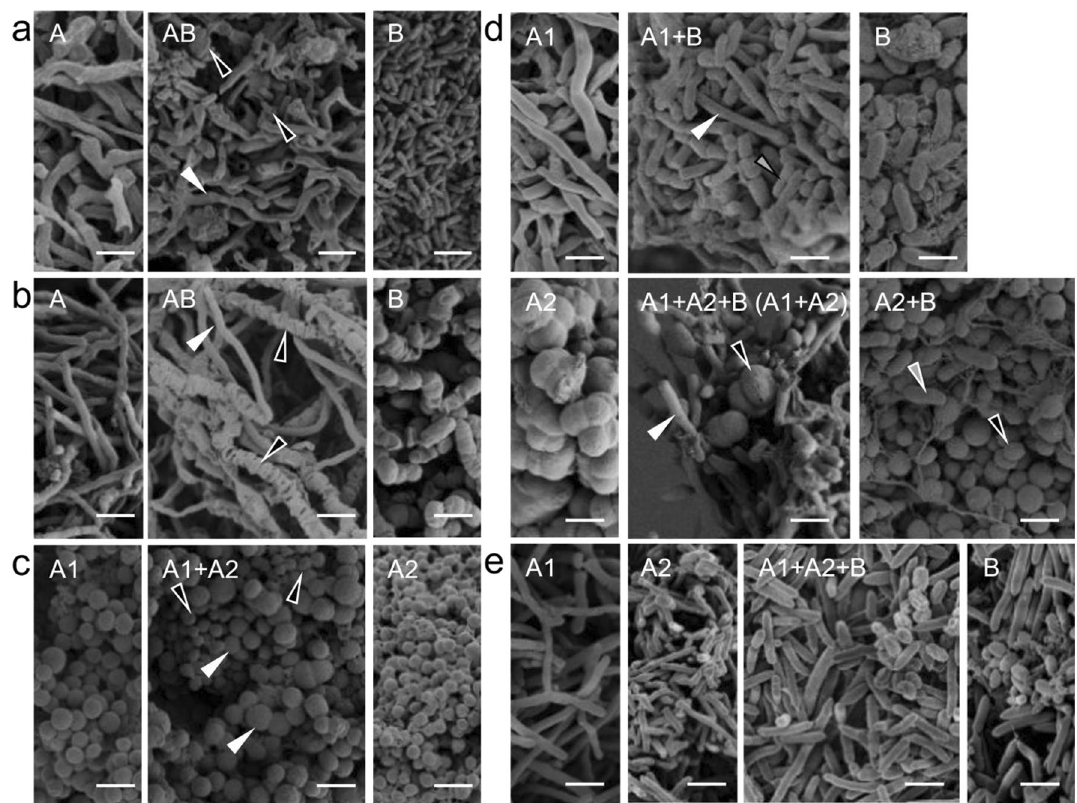
Figure 3. Scanning electron microscope image of co-isolated filamentous or cocci-shaped actinomycetes and other bacteria in co-culture. ( a ) Left image: monoculture of HEK314A. Middle image: co-culture of HEK314A/B. Right lower image: monoculture of HEK314B. White arrow indicates HEK314A filamentous cell and blank arrow indicates HEK314B bacilli-shaped cell. ( b ) Left image: monoculture of HEK830A. Middle image: co-culture of HEK830A/B. Right image: monoculture of HEK830B. White arrow indicates HEK830A filamentous cell and blank arrow indicates HEK830B bacilli-shaped cell. ( c ) Left image: monoculture of HEK654A1. Middle image: co-culture of HEK654A1/A2. Right image: monoculture of HEK654A2. White arrow indicates HEK654A1 large cocci-shaped cell and blank arrow indicates HEK654A2 small cocci-shaped cell. ( d ) Upper left image: monoculture of HEK652A1. Upper middle image: co-culture of HEK652A1/B. Upper right image: monoculture of HEK652B. Lower left image: monoculture of HEK652A2. Lower middle image: co-culture of HEK652A1/A2/B. Lower right image: co-culture of HEK652A2/B White arrow indicates HEK652A1 cell, blank arrow indicates HEK654A2 cell and gray arrow indicates HEK652B cell. ( e ) Left image: monoculture of HEK282A1. Left middle image: monoculture of HEK282A2. Middle image: co-culture of HEK282A1/A2/B. Right image: monoculture of HEK282B. (Scale bar = 2